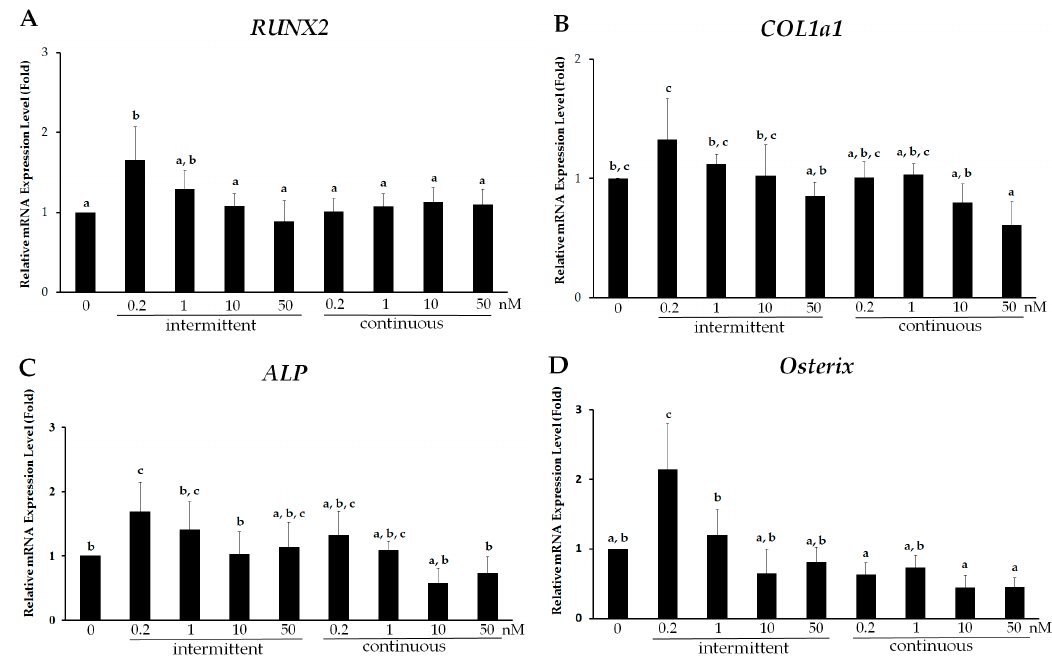
Figure 1. Intermittent administration of parathyroid hormone (PTH) (1–34) enhances osteogenesis in human mesenchymal stem cells (hMSCs). Relative mRNA expression of osteoblast-specific genes ( A ) RUNX2 ; ( B ) COL1a1 ; ( C ) ALP and ( D ) Osterix , assessed by real time quantitative PCR, from hMSCs on day 7 of osteogenic induction and after treatment with 0.2, 1, 10, and 50 nM PTH (1–34) using two modalities: intermittent: 2 h per day for 7 days and continuous: every 2 days for 7 days. Data are represented as mean ± SD ( n = 4). Statistical data analysis was performed by performing one-way ANOVA with Tukey’s post-hoc tests. Different letters represent significant differences between groups; those with the same letters were not significant ( p < 0.05).